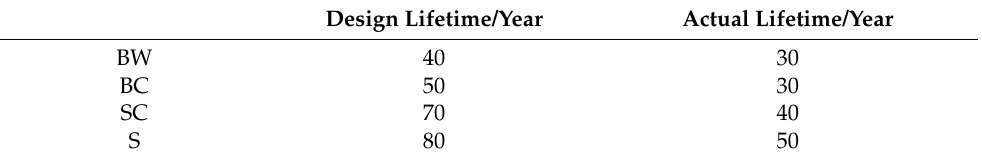
Table 2. The lifetime of residential buildings with different building